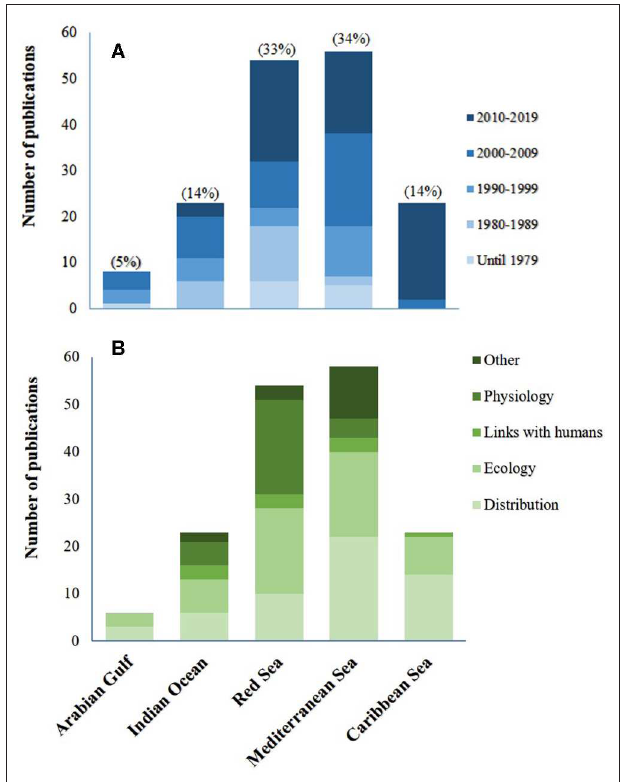
FIGURE 5 | (A) Number of publications per decade and region (based on Table S1 ). (B) Number of publications according to the paper’s general field of study (category 1—physiology, ecology, distribution, links with humans, or other), per